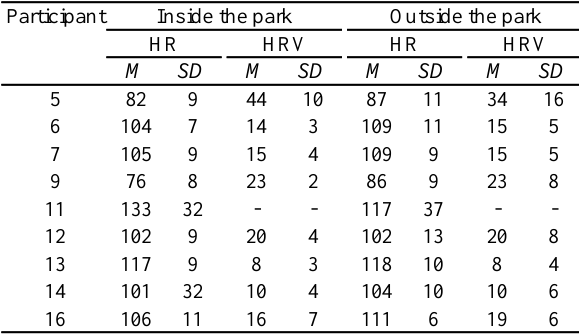
Table 1. Means (M) and Standard Deviations (SD) of HR and HRV inside and outside the park area Seven out of nine participants have lower HR values while being inside the park area. Only one participant shows increased HR in the park (see figure